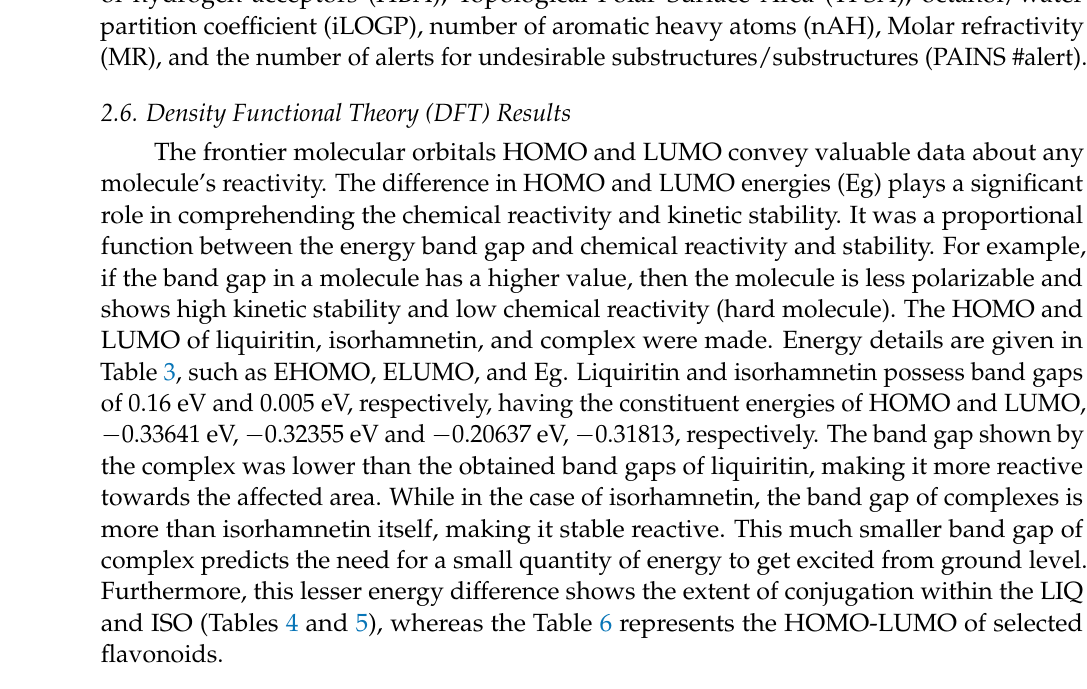
Table 3. Frontier molecular orbitals such as HOMO and LUMO selected flavonoid